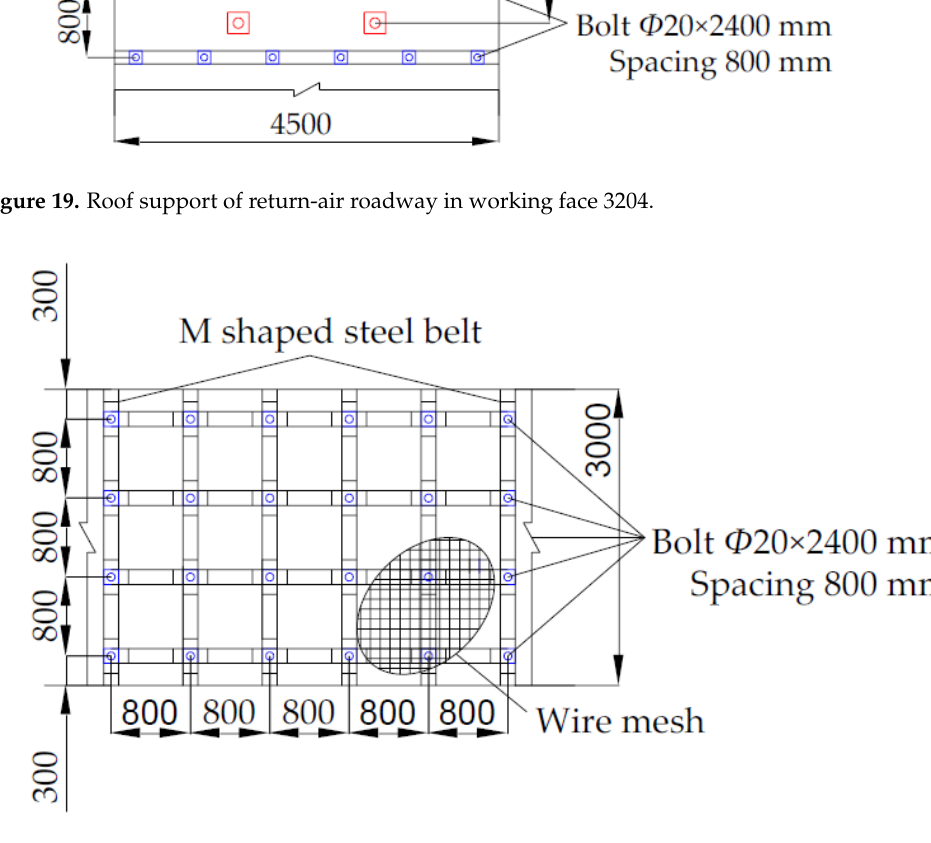
Figure 20. Side support of return-air roadway in working face 3204.